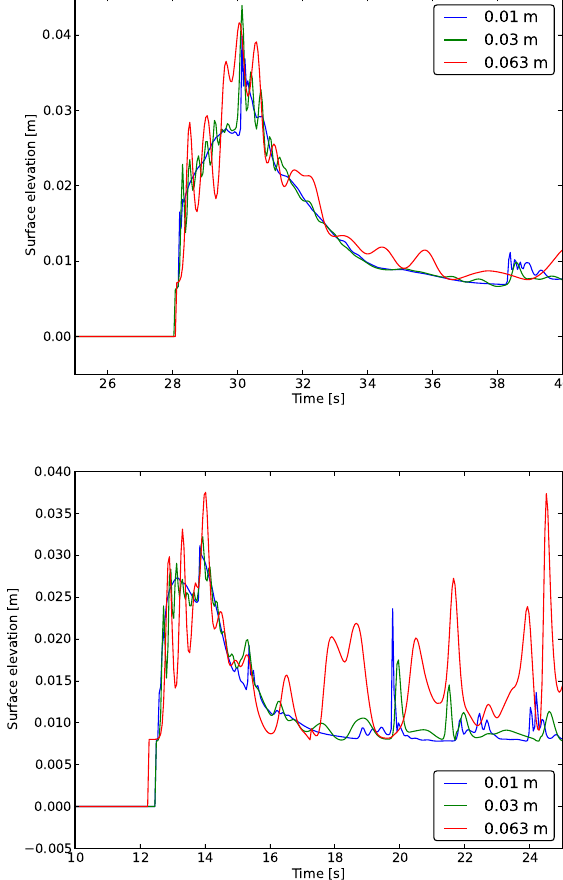
Figure 8. Convergence tests for tsunami propagation using GloBouss. The figure shows the surface elevation (mariograms) at gauges D2 (upper panels) and E2 (lower panels) as a function of time. The labels refer to the resolution of each simulation. We note that for the blue curve (finest resolution), the simulation is termi- nated after about 17s due to instability.